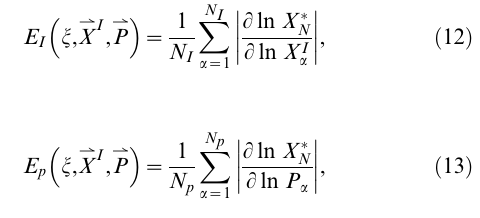
Figure 14. Variations in the Pearson test within individual networks. When the Pearson test is performed using two different definitions of F ad and F nad , small variations can be observed within individual networks. In (A) we show an example where a network’s time-course (blue) is deemed TR when the definition, F ad (red) and F nad (green) of equations (6) and (7) is used ( r 1 w r 2 ), but NP when the definition, F 0 v r 0 (gray) of equations (10) and (11) is used instead ( r 0 ). (B) is an example where the two tests agree ( r 1 w r 2 and r 0 1 2 (green), r 0 (pink), and r 0 (gray) values over the space of networks. Networks where the two tests (i.e., Pearson test using the two different definitions) 1 2 differ are shown in black (note that only their r 1 values are colored in black to avoid showing the same network 4 times).